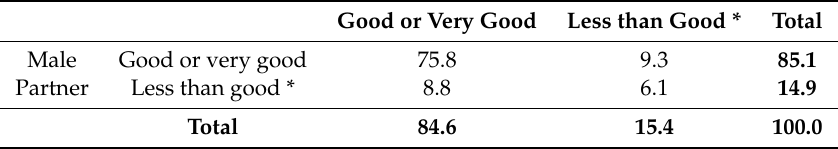
Table 4. Self-assessed health status and health status of individuals from co-residing couples aged 30–59. Spain 2012.